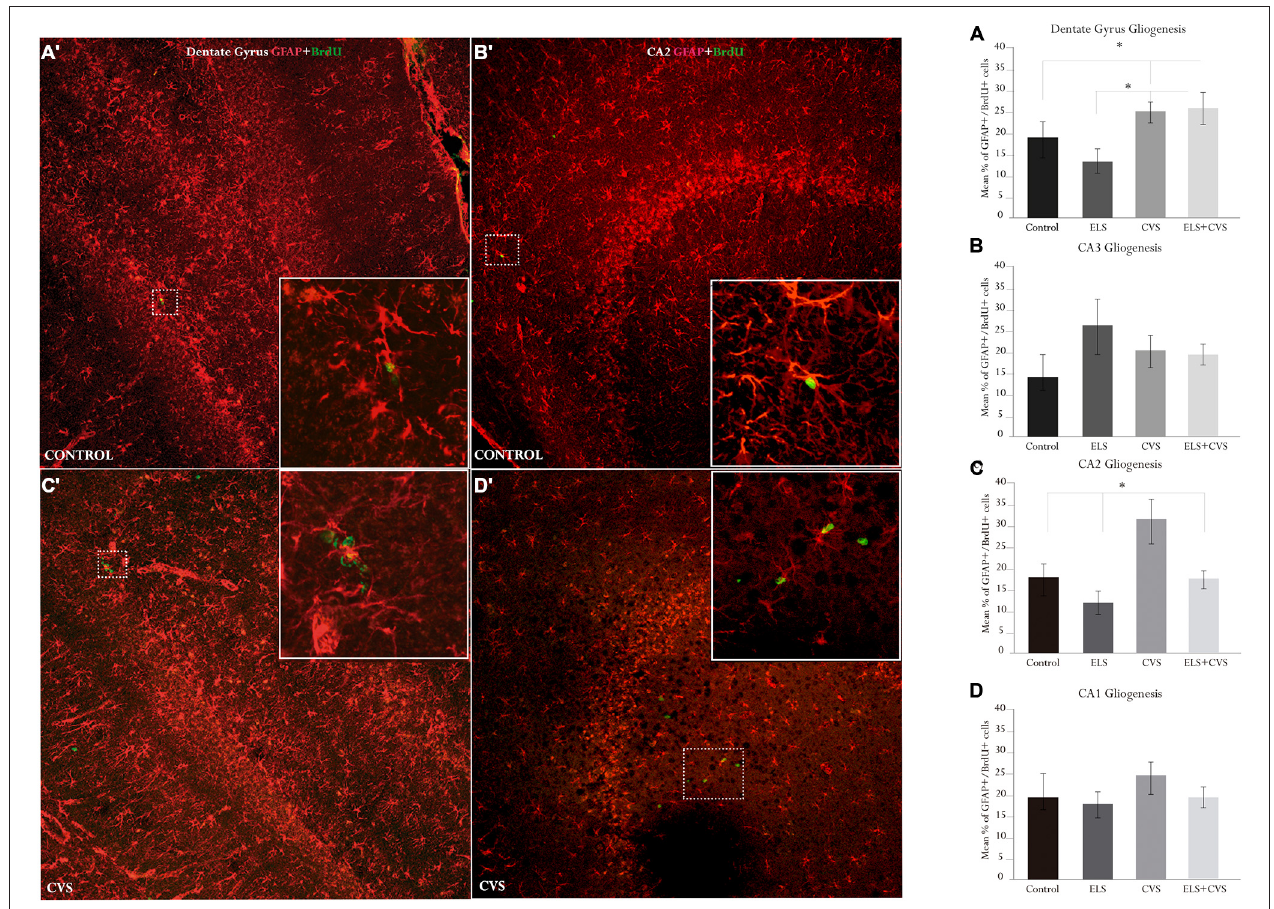
+ BrdU-positive cells in the CA2 region ( ∗ p < 0.05). The ELS-exposed rats exhibited an increase in the numbers of GFAP + BrdU-positive cells in the CA3 region ( ∗ p < 0.05). The left panel illustrates co-labeling in the two statistically relevant regions: (A (cid:48) ) DG, and (B (cid:48) ) CA2 (slices 730 µ m × 730 µ m). The white boxes in (C (cid:48) ) and (D (cid:48) ) illustrate co-labeling; the round green cells are BrdU+, and the star-shaped red cells are